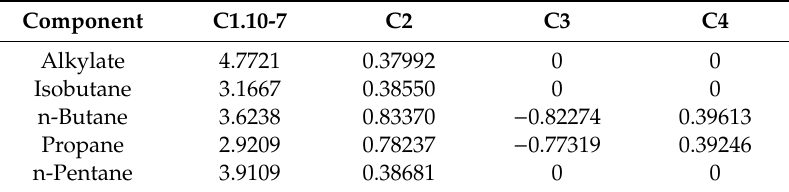
Table 4. Molar heats of vaporization. Coe ffi cients obtained from